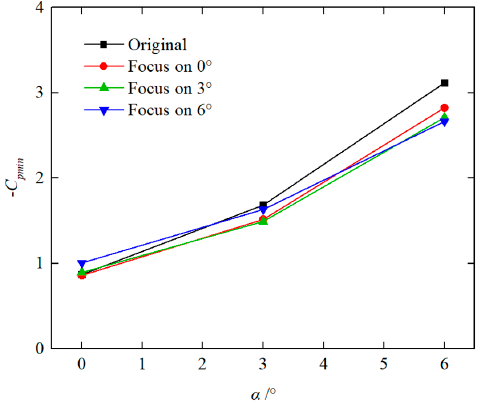
Figure 6. Comparison of − C pmin values.